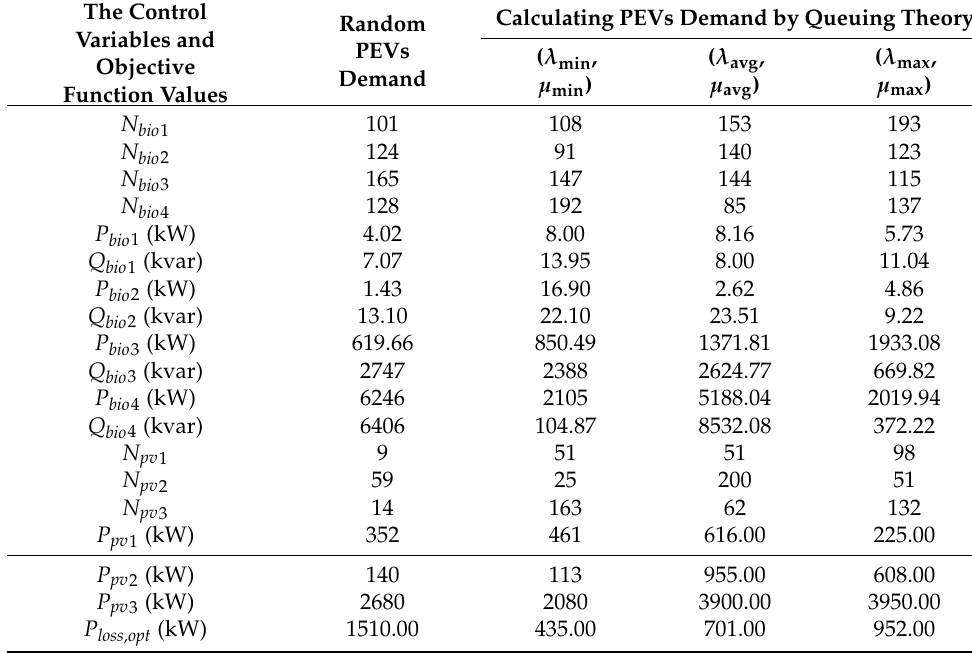
Figure 10. Optimal power loss when calculating PEV demand by maximum queuing parameters. Table 3. The simulation results for four cases of the optimization manners.